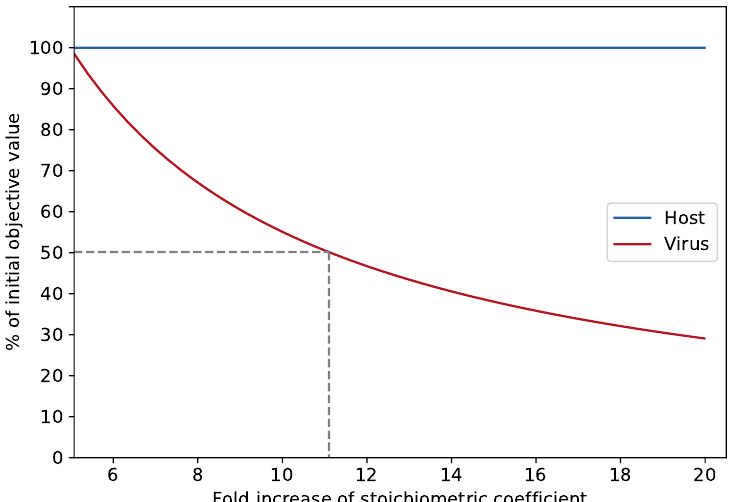
Figure 5. Influence of stoichiometric coefficient on reduction of VBOF during METS knock-out. With increasing factorization of phosphatidylcholine’s stoichiometric coefficient, the objective value of the VBOF’s optimization decreases during the knock-out of the methionine synthase ( METS ) reaction. The hosts growth maintenance stays at 100%. At an eleven-fold increase of the initial stoichiometric coefficient extracted from the host’s maintenance function results in a 50% decrease of the viral growth